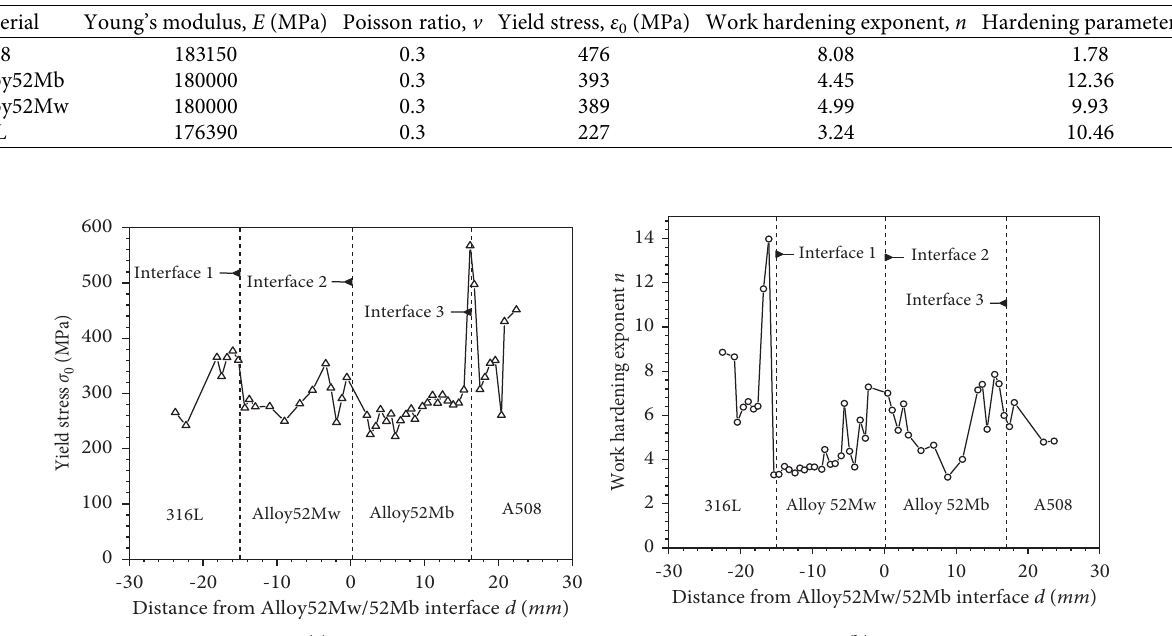
Table 2: Mechanical property data of the four materials at 340 ° C [14, 15].